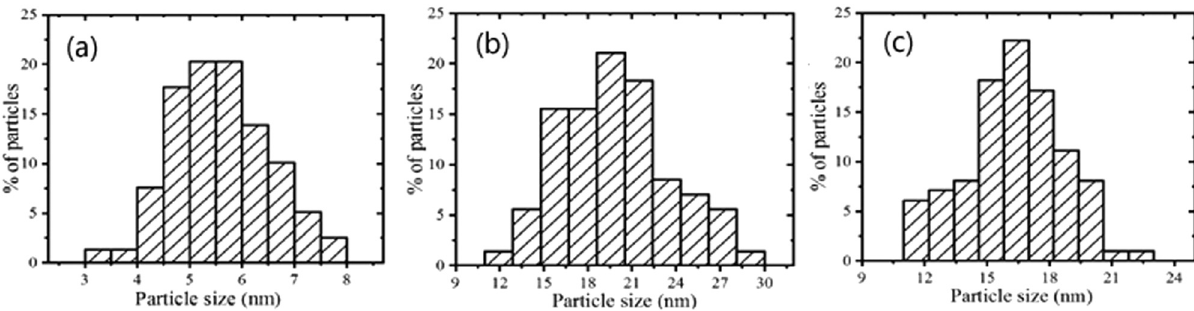
Figure 3: Size distribution of products synthesized at ( a ) 300°C ( b ) 400°C ( c ) 500°C and 30 MPa when Ti ( SO 4 ) 2 acted as a precursor and 0.16 M KOH was